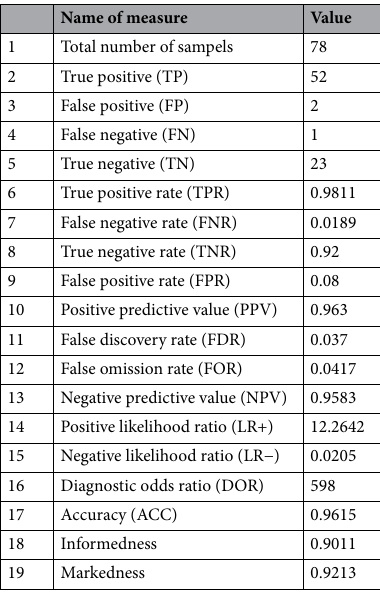
Table 5. Quality indicators of ANN No. 1. The indicators were calculated based on the results from the validation subset.